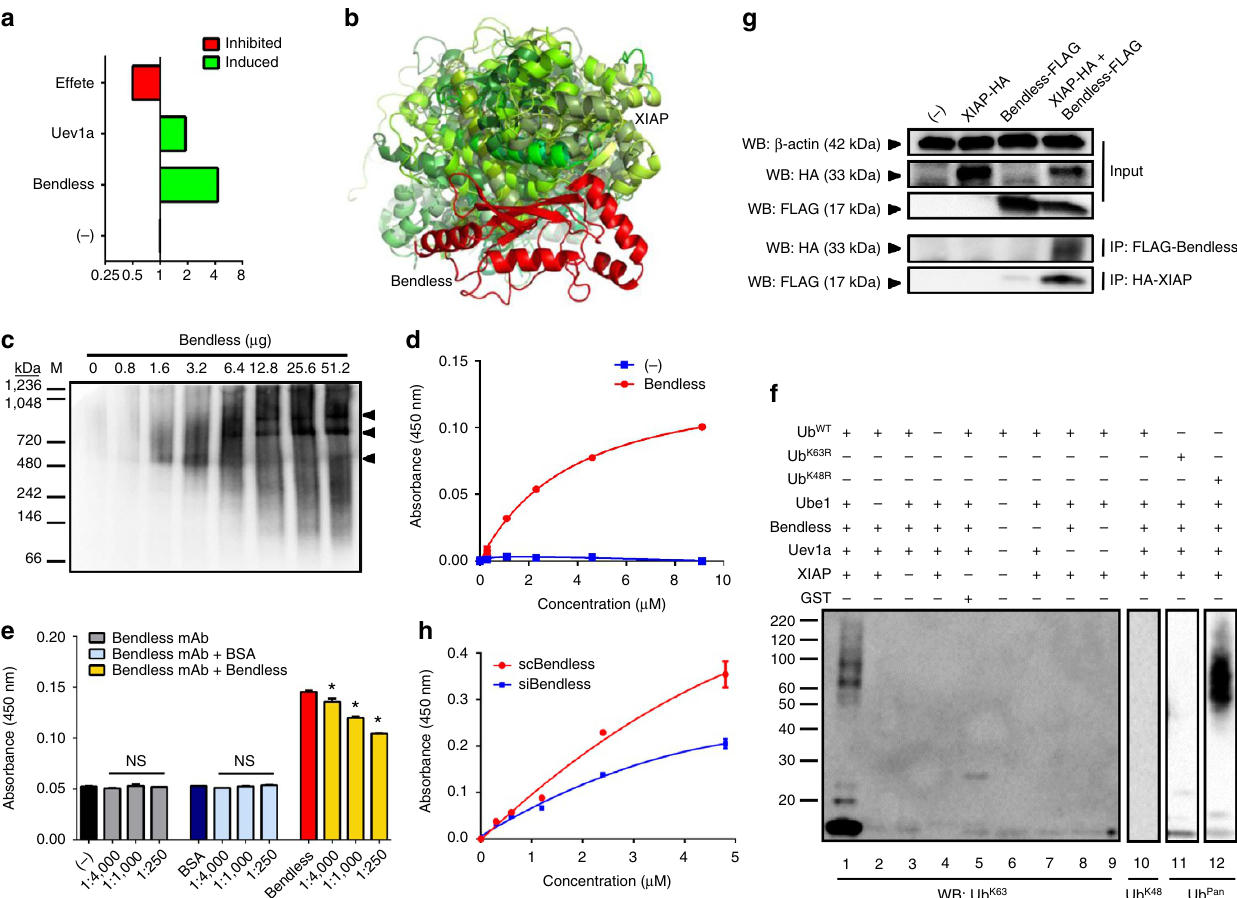
Figure 2 | Bendless-XIAP molecular interactions. ( a ) Protein differential expression on A. phagocytophilum infection of I. scapularis ticks based on iTRAQ proteomics data deposited on the Dryad repository database. ( b ) Structural docking model demonstrating the interaction between I. scapularis XIAP and the UbcH13 homologue, Bendless. ( c , d ) Native gel and ELISA analysis of a fixed amount of recombinant (0.2 m g) XIAP incubated with increasing amounts of recombinant Bendless. The analysis shown is one of two biological replicates. ( e ) XIAP-Bendless binding inhibition with a monoclonal antibody against the human homologue of Bendless (UbcH13). ( d , e ) The average of two technical replicates are plotted. ( f ) XIAP polyubiquitylation assay with recombinant Bendless (lane 1). Control conditions were performed in the absence of an E1 enzyme—Ube1 (lanes 2 and 6), XIAP (lanes 3, 5 and 6), wild-type ubiquitin (lanes 4, 11 and 12), Bendless (lanes 6, 7 and 9) and Uev1a (lanes 6, 8 and 9). Immunoblots were probed with antibodies specific for K63- (lanes 1–9) and K48- (lane 10) polyubiquitin chains or with a pan-ubiquitin antibody (lanes 11 and 12). GSTwas used as a negative control. The Western blot (WB) shown is one of two biological replicates. ( g ) Immunoprecipitation (IP) analysis followed by WB showing the interaction between XIAP and Bendless within HEK293 T cells transfected with the indicated vectors. Input indicates normalizing amounts. The WB shown is one of two biological replicates. ( h ) ELISA with protein extracts from unfed I. scapularis nymphs that were microinjected with either a scrambled control (scBendless) or siRNA specific for bendless (siBendless) and incubated with increasing amounts of recombinant XIAP. Points are the average of 10 biological replicates with two technical replicates each. See also Supplementary Figs 1–3 and